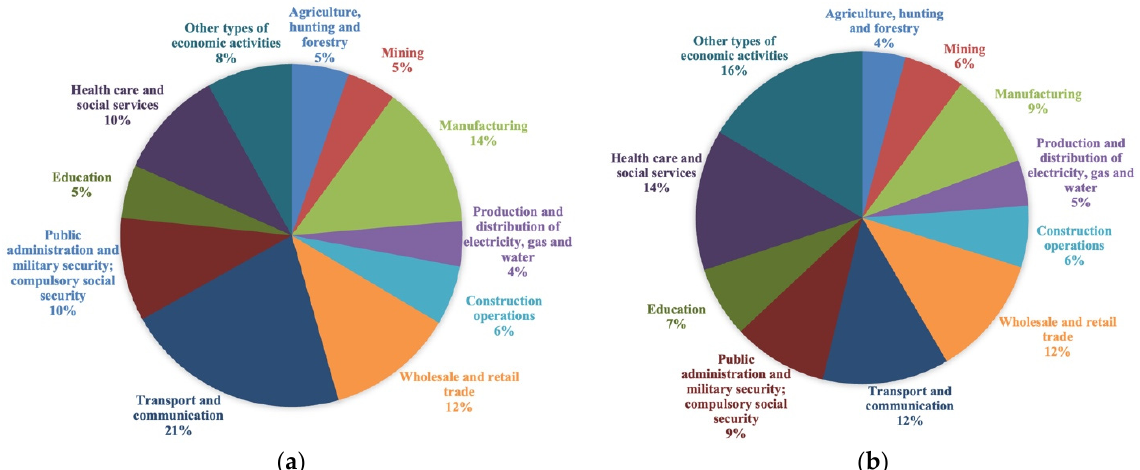
Figure 2. Structure of Republic of Buryatia’s economy ( a ) 2010; ( b ) 2018.